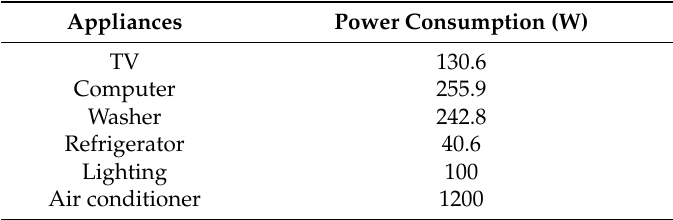
Table 4. Household appliances and their energy consumption [25].